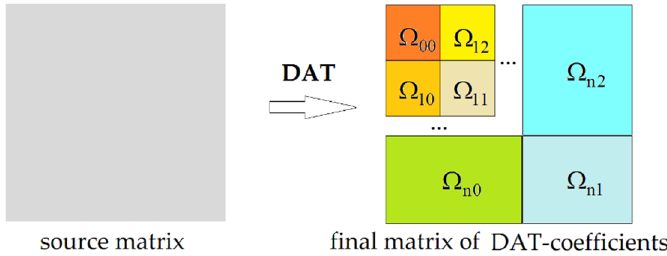
Figure 5. Discrete atomic transform of a matrix: the procedure DAT2 of depth n.